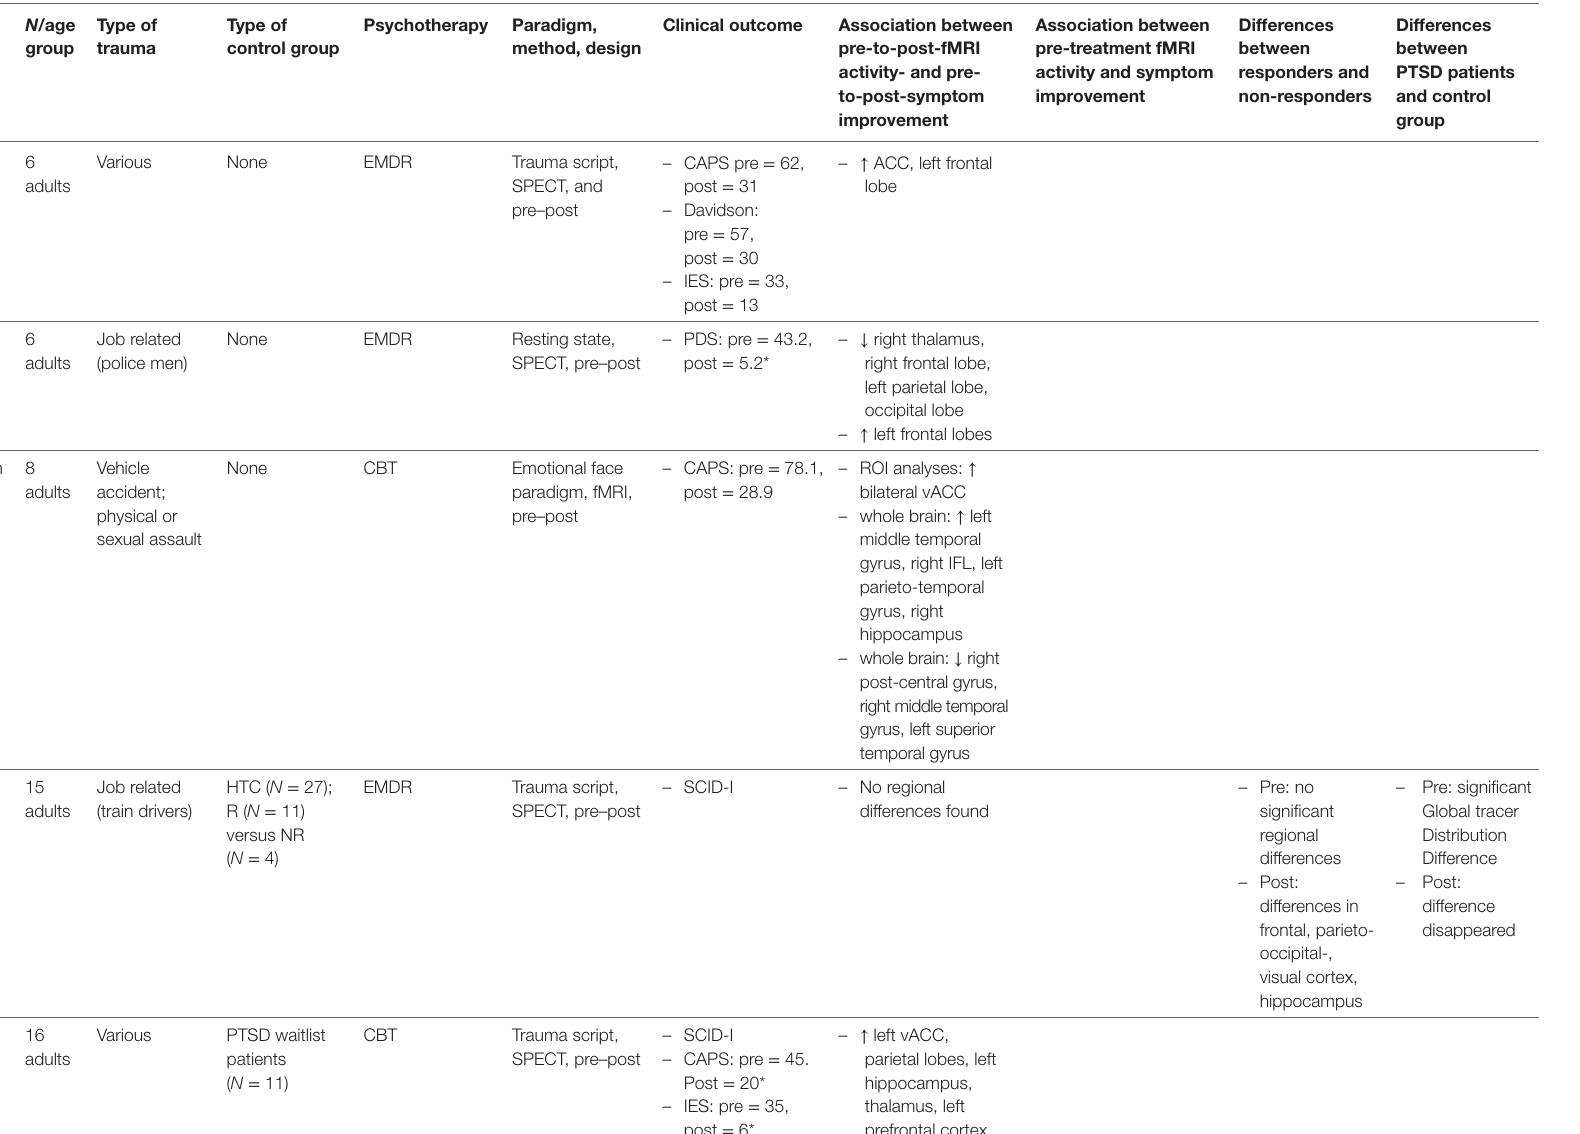
Table 1 | studies that investigated neural correlates of psychotherapeutic treatment of